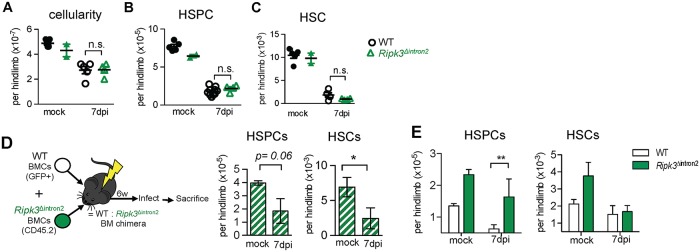
Targeting RIPK3 kinase activity protects HSPCs from IOE infection-induced depletion in mixed BM chimeric mice.(A-C) BM cellularity (A), HSPCs (B), and HSCs (C) in mock or infected WT and Ripk3Δintron2 mice 7 d.p.i. n = 4–5 mice/infected group; n = 2–4 mice/mock group. (D) Generation and treatment of Ripk3Δintron2:WT mixed BM chimeric mice, and numbers of HSPCs and HSCs in mock and IOE-infected chimeric mice 7 d.p.i. (E) Numbers of WT (white bars) and Ripk3Δintron2 (green bars) HSPCs and HSCs in mock and IOE-infected chimeric mice 7 d.p.i. n = 5–6 mice/group.*P < 0.05, **P < 0.01.